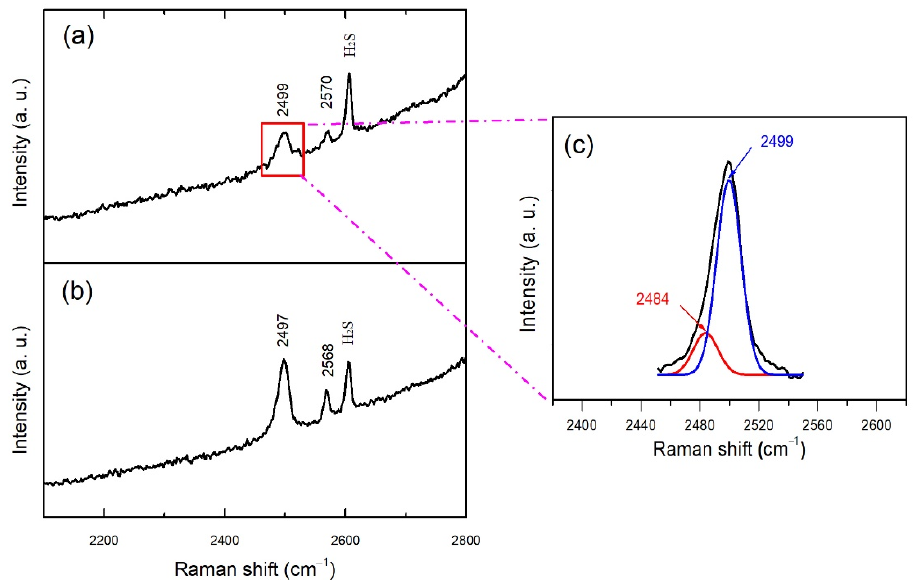
Figure 6. Raman spectra of fluid inclusions showing the H 2 S 2 -related bands at approximately 2499 and 2570 cm –1 : ( a ) Raman spectrum without baseline correction of the inclusion as shown in Figure 4a; ( b ) Raman spectrum without baseline correction of the inclusion as shown in Figure 4b; ( c ) deconvolution of the 2499 cm –1 band reveals a hidden band centered at 2484 cm –1 . The bands at 2484 and 2499 cm –1 reflect the respective H–bonded and non–H–bonded SH-stretching vibrations of the H 2 S 2 · · · S 8 · · · H 2 S 2 complex.